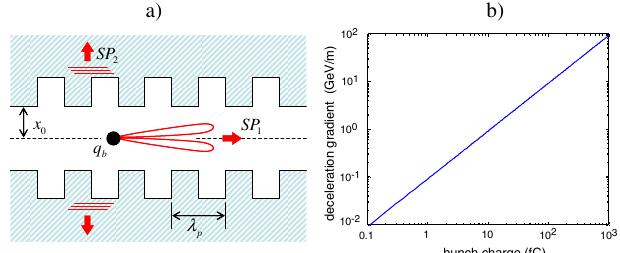
FIG. 4. (Color) (a) Schematic of the main possible radiation mechanisms for a periodic structure. (b) Approximate decelerat- ing gradient versus bunch